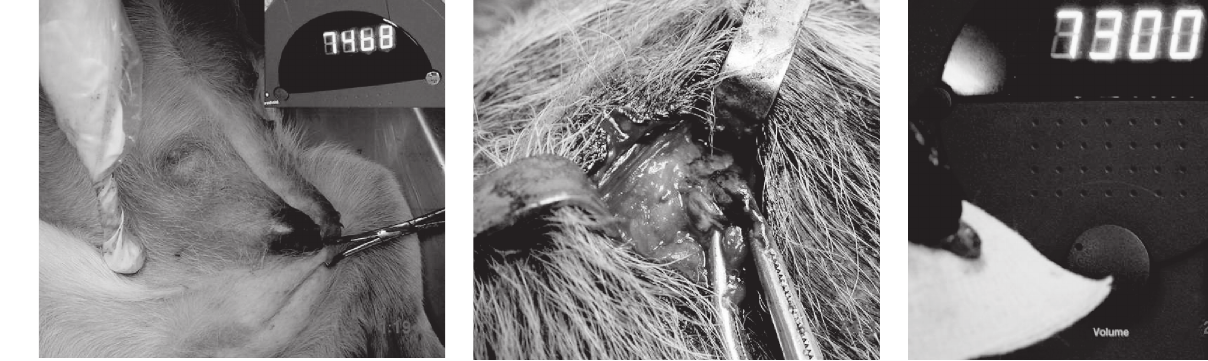
FIGURA 2 – Identificação do linfonodo sentinela da mama da cadela, corado pelo azul patente “in